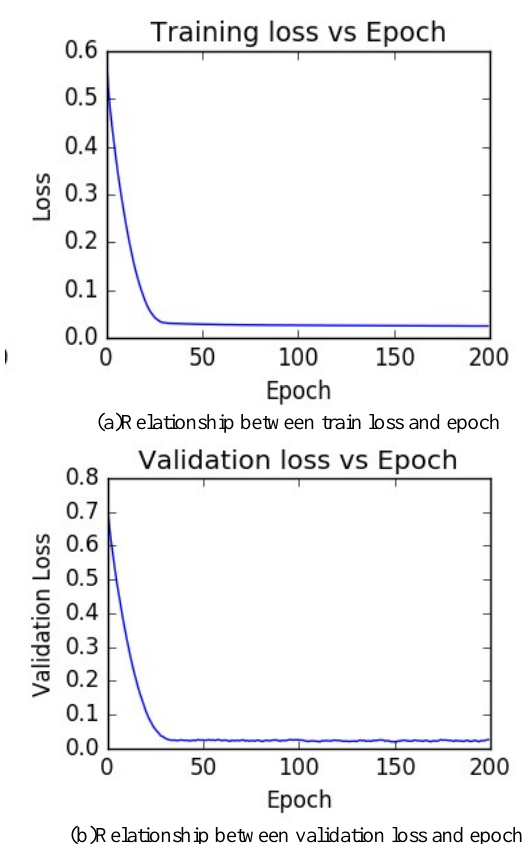
Figure 4. Relationship between LSTM training error and training